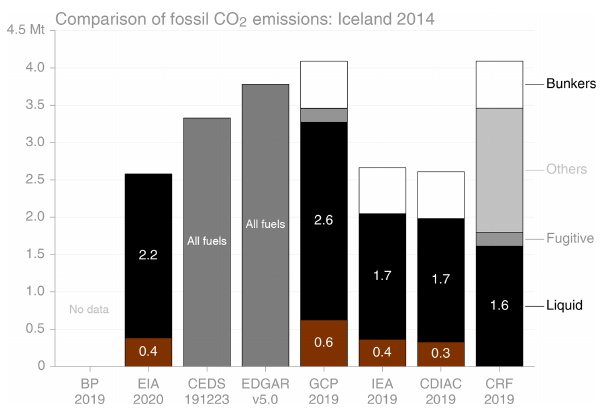
Figure 13. Comparison of fossil CO 2 emissions from seven sources for the Netherlands, Belgium, and Luxembourg.